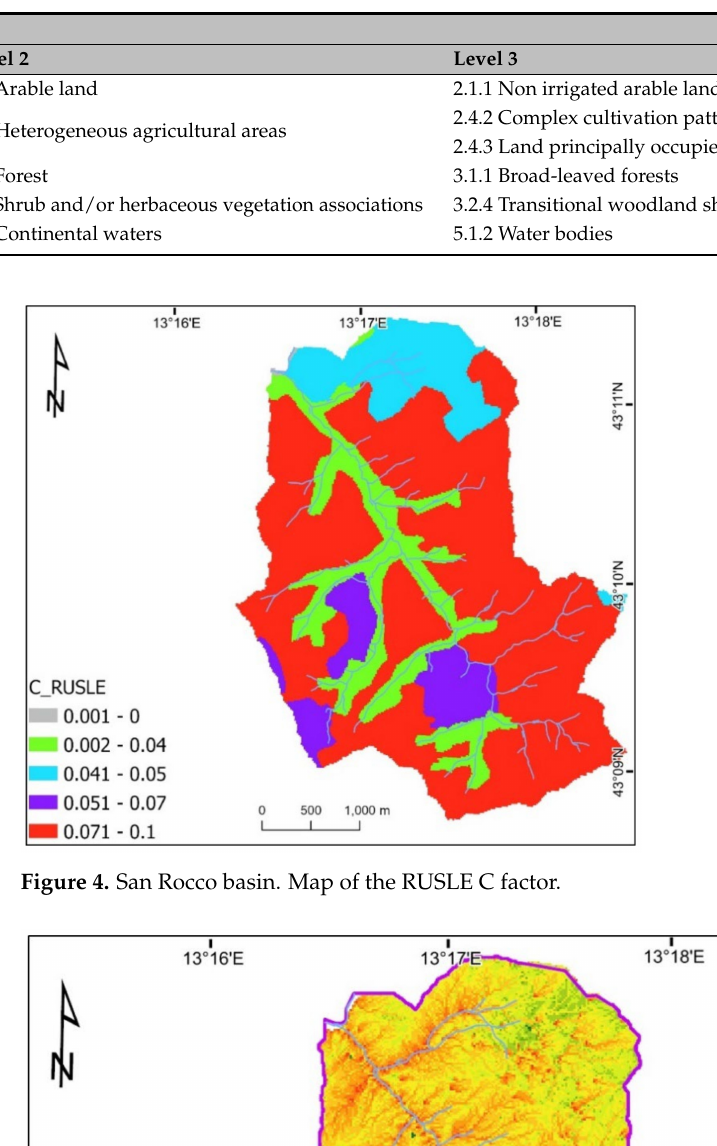
Table 3. Relationship between CLC soil classes and C factor for the San Rocco basin.